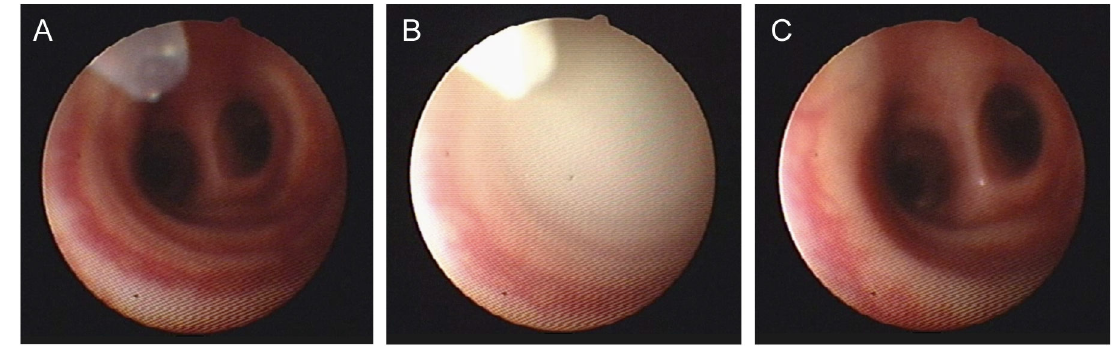
Figure 1. Administration of oxytocin powder formulation to the sheep lung. Screen images taken (A) prior to; (B) during and (C) 2 min after pulmonary administration of the oxytocin powder formulation above the first bronchial bifurcation.